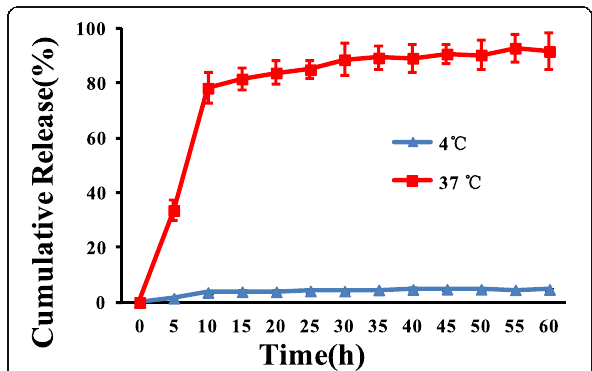
Fig. 3 In vitro time-dependent hirudin release from hirudin/ liposome complex at 4 °C and 37 °C